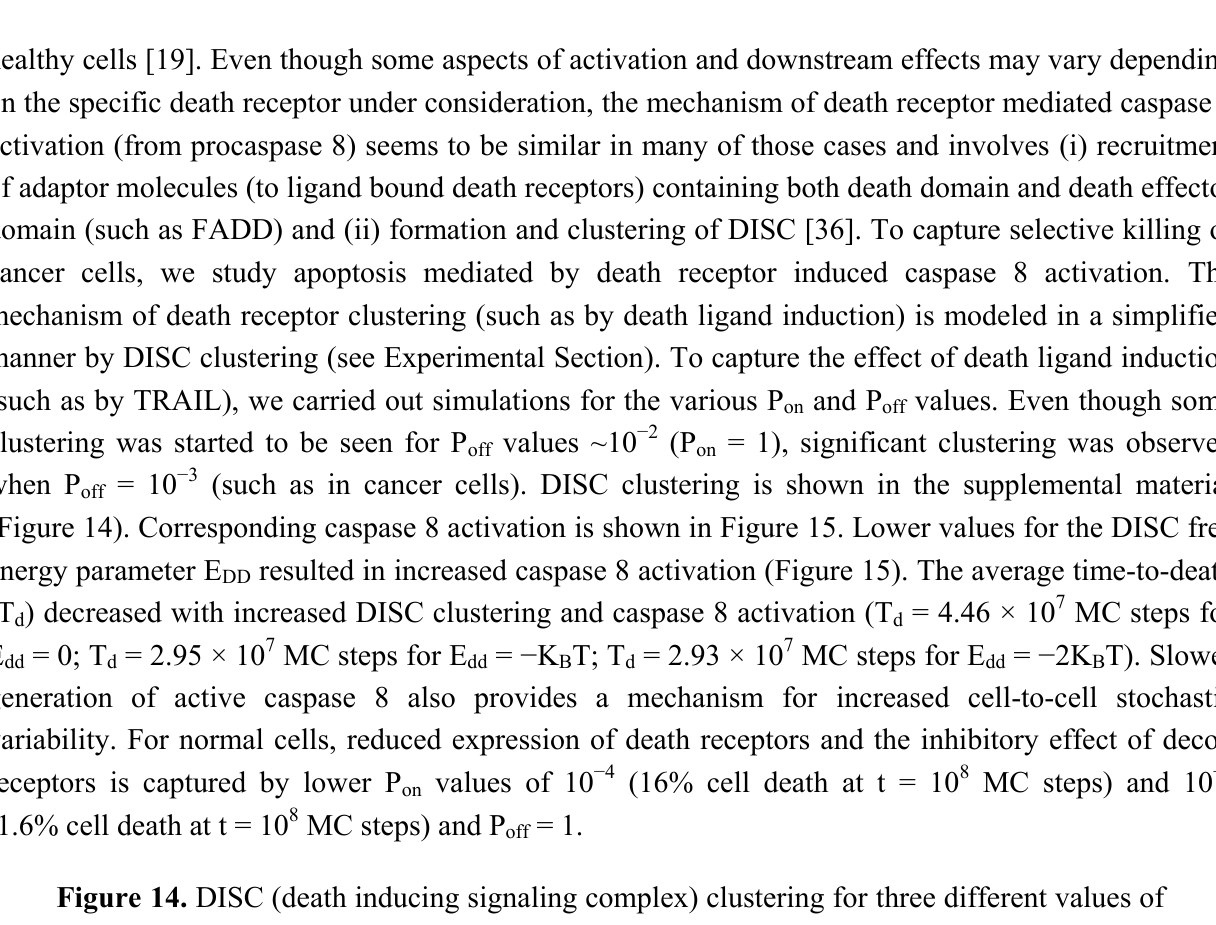
= 0, −K T and −2K T ( a , b , c ). Adapter dd B B